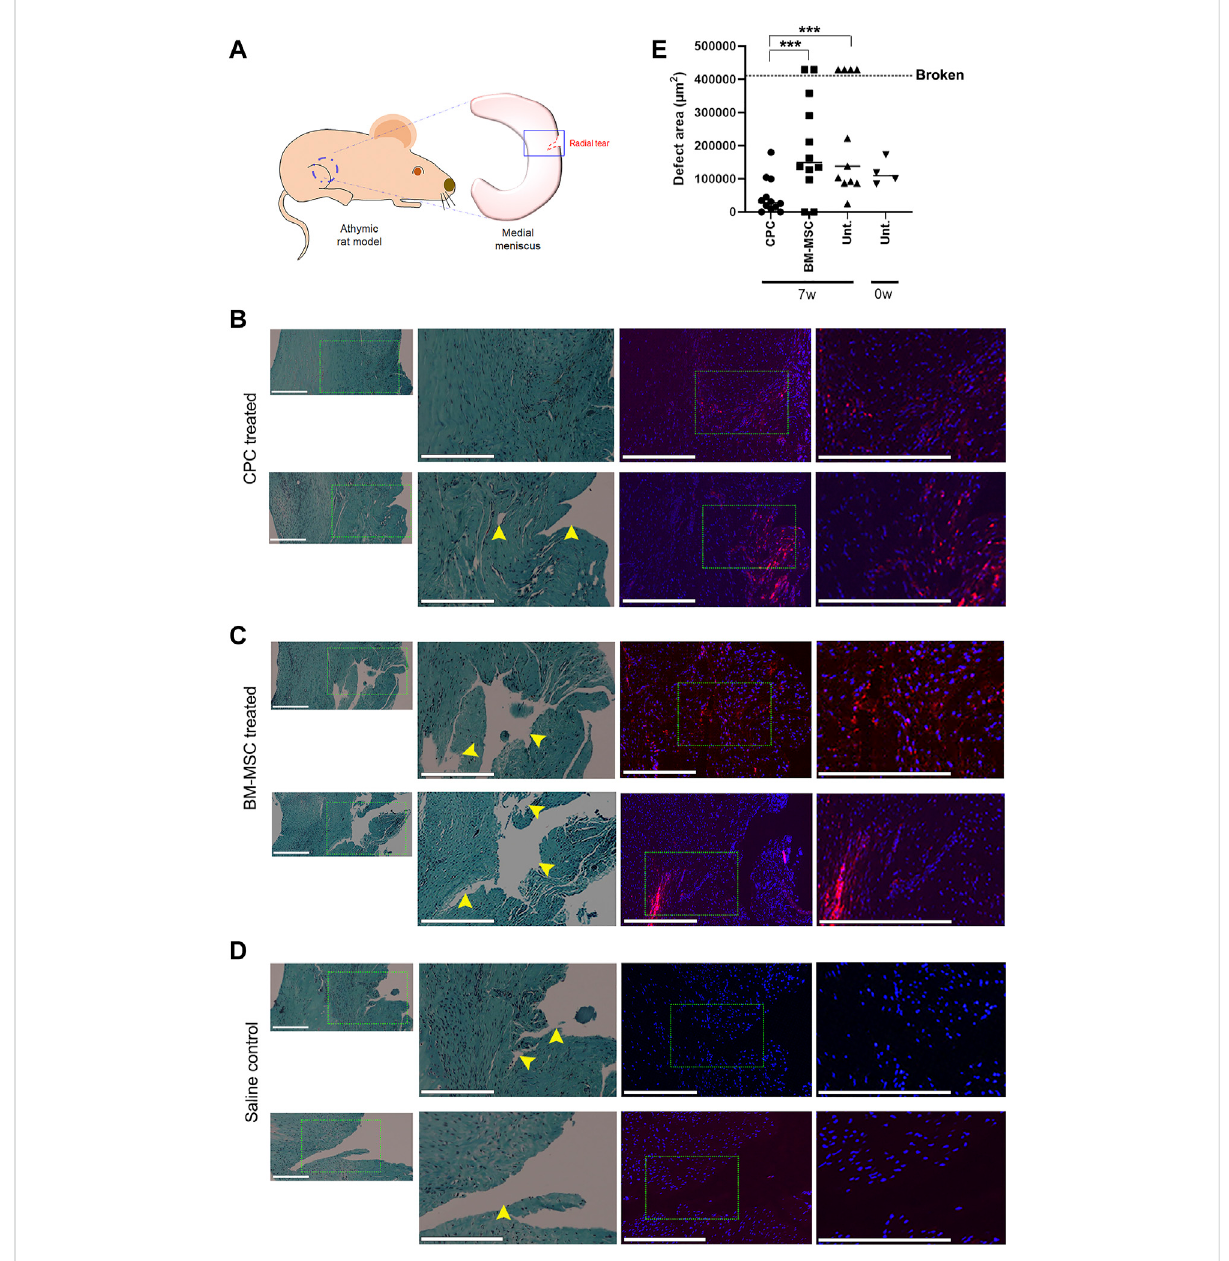
FIGURE 3 Intra-articularinjectionofCPCL3followingmeniscustearingstimulates fi brocartilagerestorationandhealing. (A) Aradialtearwascreatedinthe outer third of the medial meniscus of skeletally mature athymic rats as shown in the diagram. Histology of meniscus tears 7 weeks following treatment with (B) CPCL3, (C) BM-MSCL, or (D) saline vehicle alone is shown. Left panels show sections stained with Safranin O/Fast green, while fl uorescence imaging panels represent a sister section taken ~150 — 300 µm away from the aforementioned section that has been stained with Dapi.Rightmost fl uorescentpanelsarehighermagni fi cationimagesoftheselectareainscribedbythedottedlineintheDapistainedimage.Nucleiof all cells (both native meniscus cells and injected cells) are stained with Dapi (blue). In the cell treatment groups, a total of 3.2 million fl uorescently labeled cells (red) were injected into the joint capsule following meniscus injury. (E) Open areas remaining within the meniscal tear channel was quanti fi ed by image analysis and compared across experimental groups. A 0-week control group was used to determine the open area of the meniscal tear before healing, or further tearing due to the in vivo environment, can take place. Data points above the dotted line indicates menisci that were broken in two at the time of harvest. Representative images in panels B, C and D were not obtained from these broken menisci samples. Scale bars represent 400 µm. N ≥ 8 per group. ***, p ≤